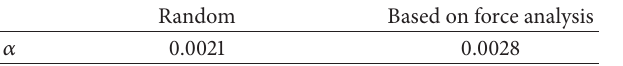
Table 3: Comparison of the two 𝛼